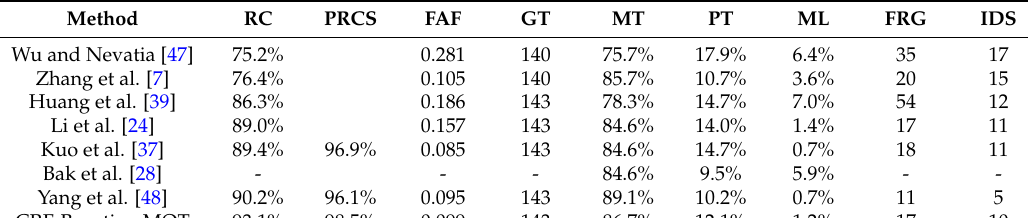
Table 3. Performance evaluation on CAVIAR.